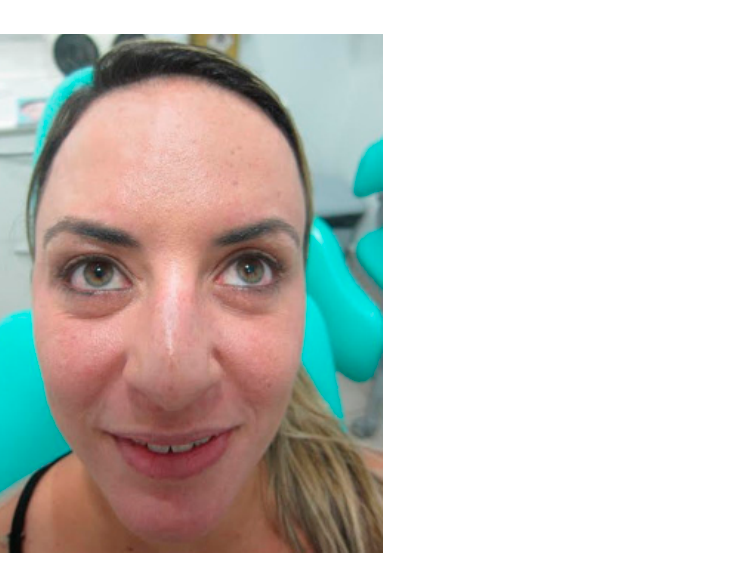
Figure 8. Re-evaluation of the patient after more than 6 months. Observe the difference of the muscle’s activity.